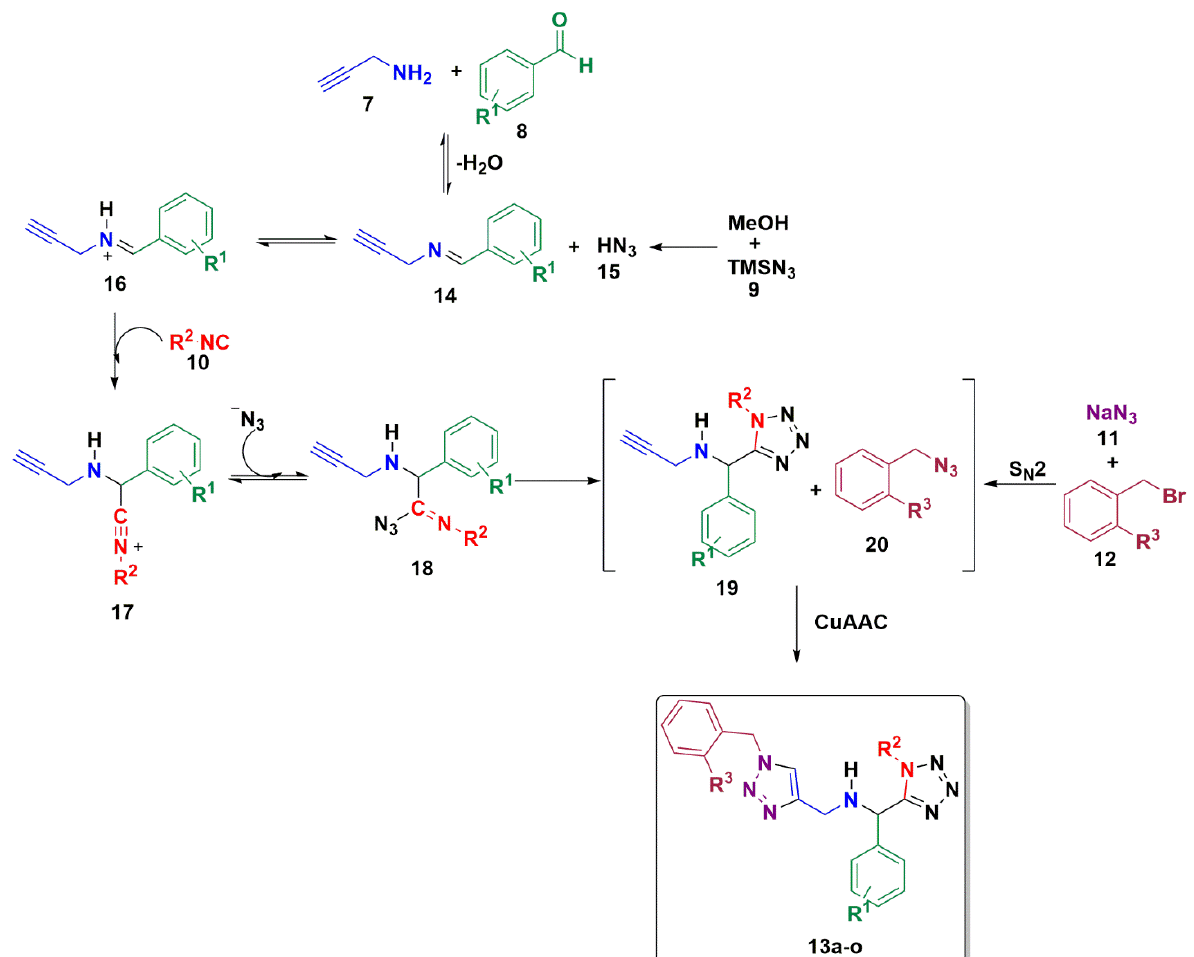
Scheme 2. Cascade process for the synthesis of target molecules 13a – o